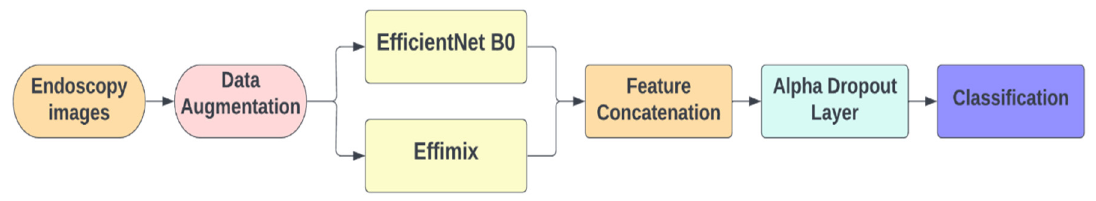
Figure 1. Architectural overview of the proposed system.